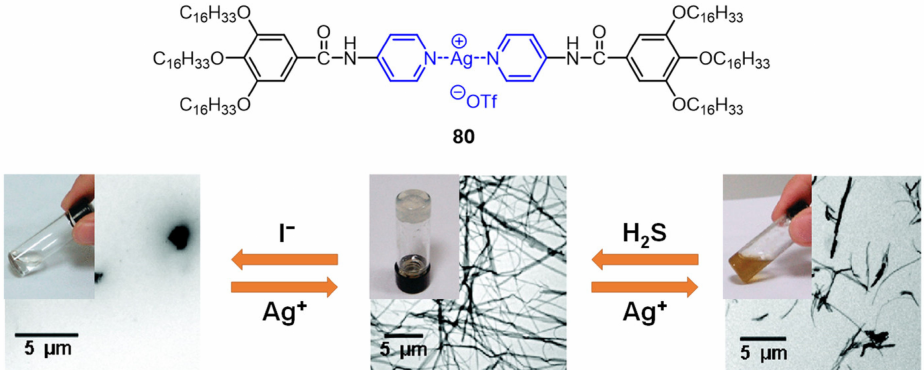
Figure 32. Photographs of the response property of the Ag-coordinated complex gel 80 toward potassium iodide and H 2 S gas, and the corresponding TEM images. Reprinted with permission from Ref. [106]. Copyright (2007), American Chemical